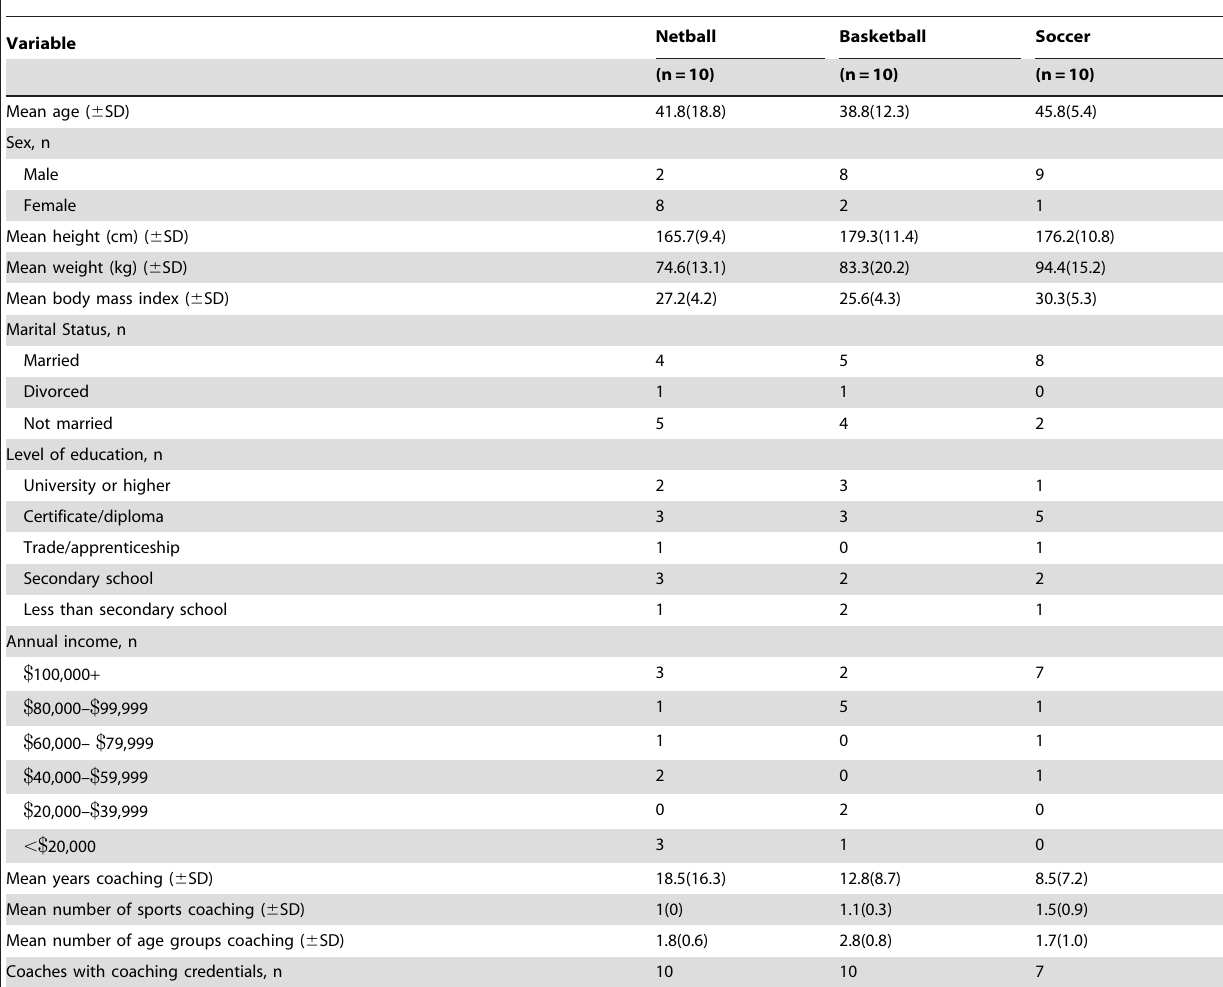
Table 2. Characteristics of Participating